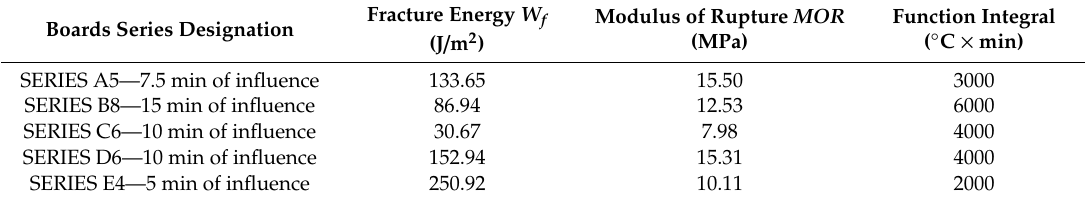
Table 3. Aggregate summary of the temperature function integral from the maximum time